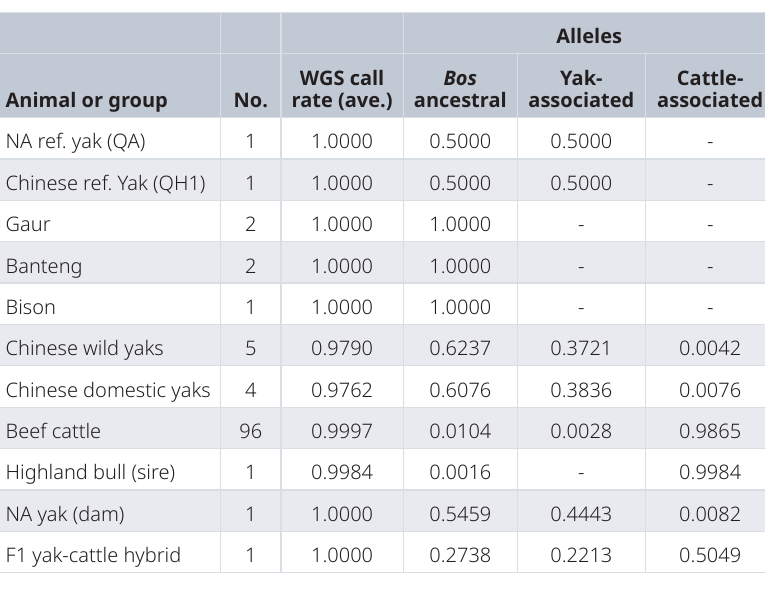
Table 1. Allele frequencies of 610 tySNPs in WGS data sets.